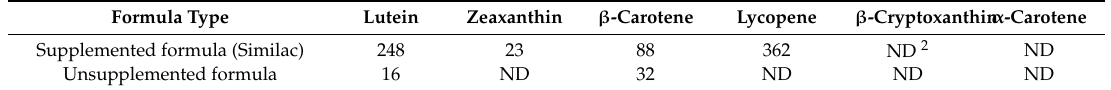
Table 1. Carotenoid profiles of the infant formulas 1 .